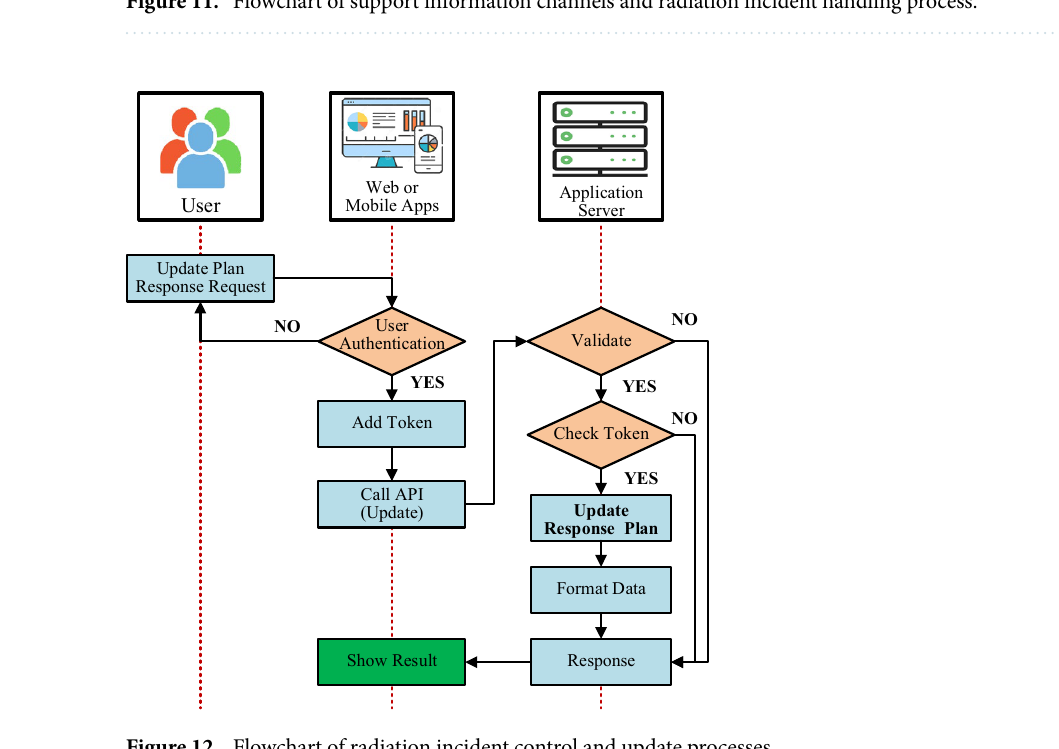
Figure 11. Flowchart of support information channels and radiation incident handling process.